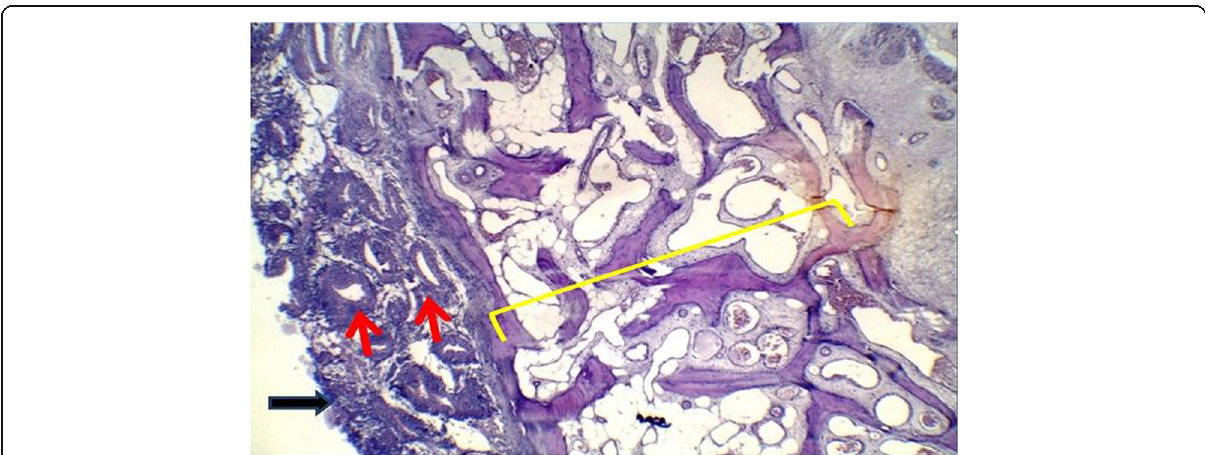
Fig. 2 Nasal turbinate showing respiratory epithelial covering (black arrow), the subepithelium is thickened by vascular spaces (red arrows) and thickened bony trabeculae